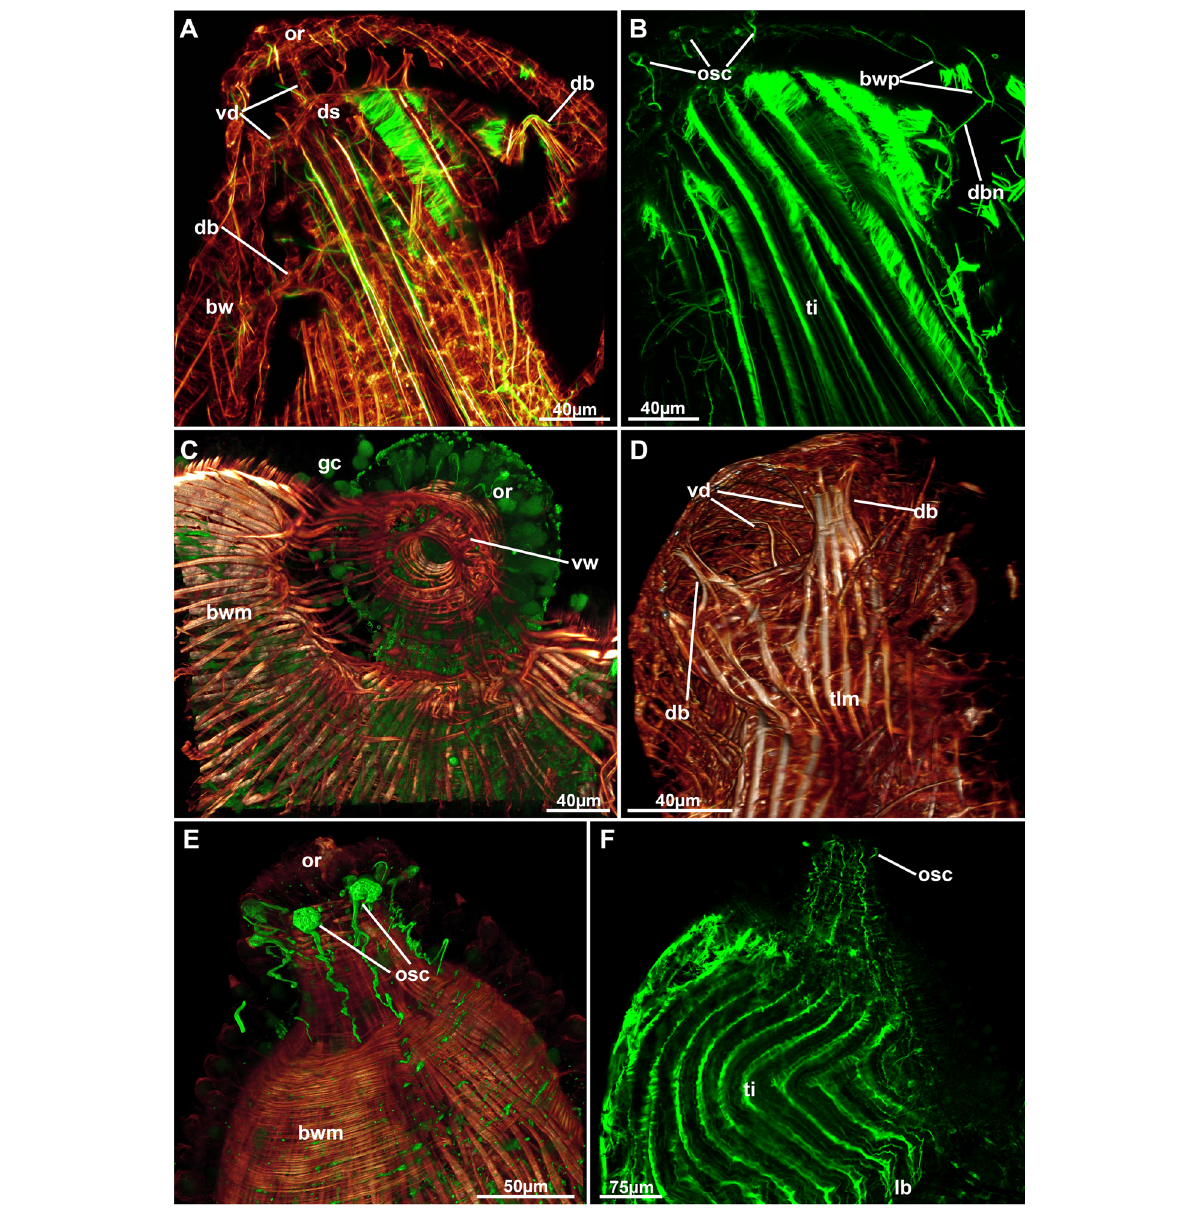
Fig. 4 Neuro-muscular system of the apertural area of Stephanella hina . Confocal laser scanning microscopy stacks based on acetylated alpha-tubulin labelling. Volume renderings, projections or optical slices. Acetylated alpha-tubulin in green LUT, f-actin in glow LUT. a Projection of a zooid with a retracted polypide showing duplicature bands and vestibular dilatators. b Thin neurite bundles traversing the duplicature bands and extending towards the conspicuous orificial cells. c Volume rendering of the orificial area of a zooid with a retracted polypide showing a closed vestibular area surrounded by stained gland cells. d Lateral view of a retracted zooid showing duplicature bands and vestibular dilatators. e Details of specific orificial cells. f Thin neurite bundles extending along the distal body wall towards the orificial cells. Abbreviations: bw – body wall, bwm – body wall musculature, bwp – body wall nervous plexus, db – duplicature band, dbn – duplicature band neurites, ds – diaphragmatic sphincter, gc – gland cell, or – orifice, osc – orificial (sensory?) cells, ti – tentacle innervation, tlm – tentacle sheath longitudinal muscles, vd – vestibular dilatators, vw – vestibular